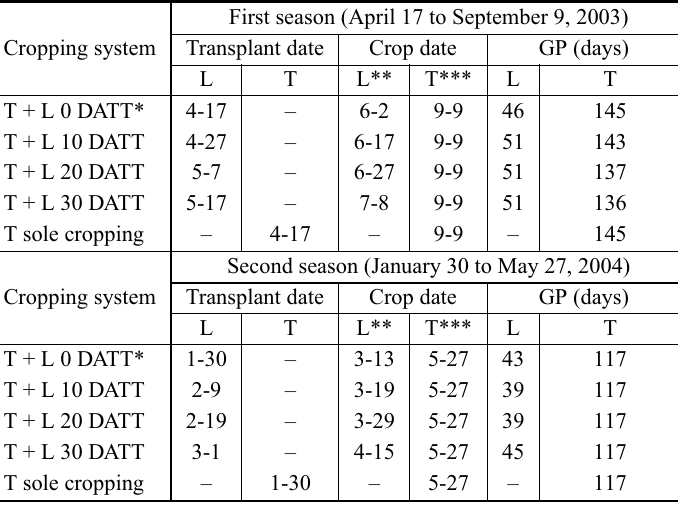
Transplanting, harvesting, and growth periods (GP) of lettuce (L) and tomato (T) of experiments 1 and 2, characterized by the transplanting of lettuce after tomato, in two cropping